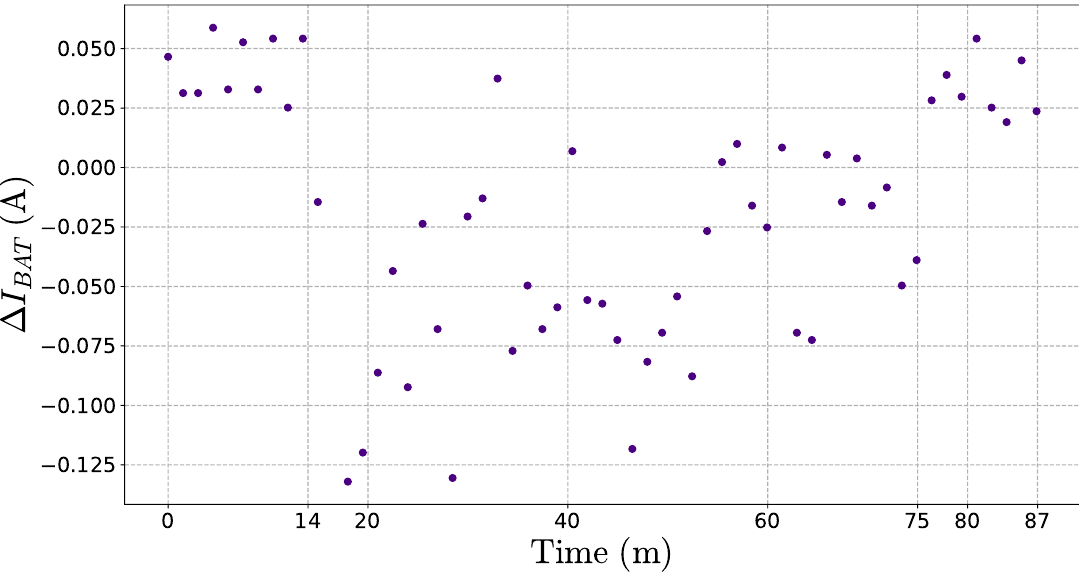
Figure 17. Time series of the difference between currents of batteries 1 and 2 ( ∆ I BAT = I BAT 1 − I BAT 2 ) during one orbit. Negative current has been defined to be charging the